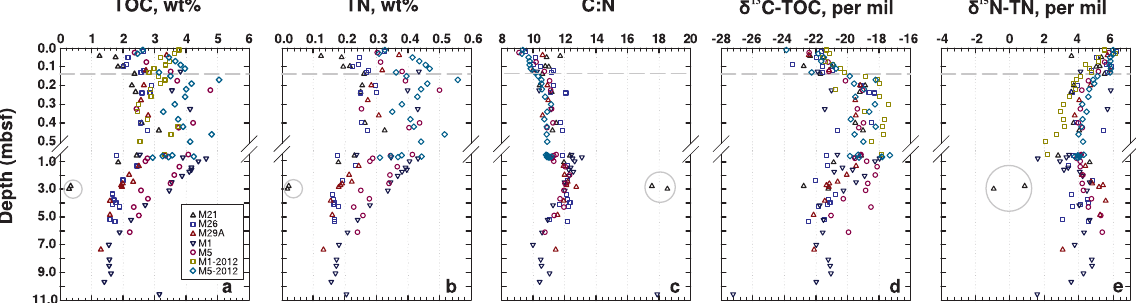
Figure 4. Sediment depth profiles of ( a ) TOC, ( b ) TN, ( c ) C:N, ( d ) δ 13 C-TOC, and ( e ) δ 15 N-TN at 5 stations in Aarhus Bay. Due to problems with the TN measurements on samples from M1-2012, these samples were omitted from ( b ) and ( c ). The horizontal grey dashed lines indicate the minimum depth of macrofaunal sediment reworking (0.14 mbsf).